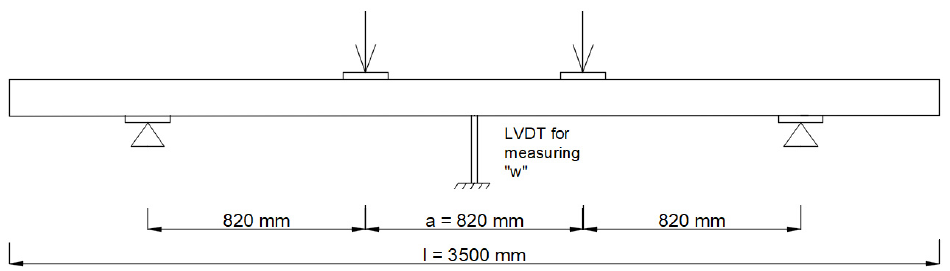
Figure 2. Static diagram of a four-point bending test to determine MOE and MOR, where LVDT–linear variable differential transformer, w–deflection.